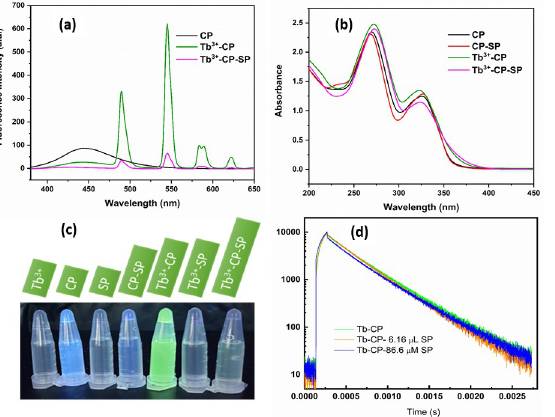
Fig 2. (a) Fluorescence and (b) UV spectra of CP, CP-SP, Tb 3+ -CP, Tb 3+ -CP-SP and Tb 3+ -SP samples with CP (0.13 mM), SP (74 μ M), Tb 3+ (0.02 mg/mL); (c) Color changes of the samples under UV lamp ( λ max = 365 nm); and (d) Life- time curves of Tb-CP, Tb-CP-6.16 μ M SP, Tb-CP-86.6 μ M SP